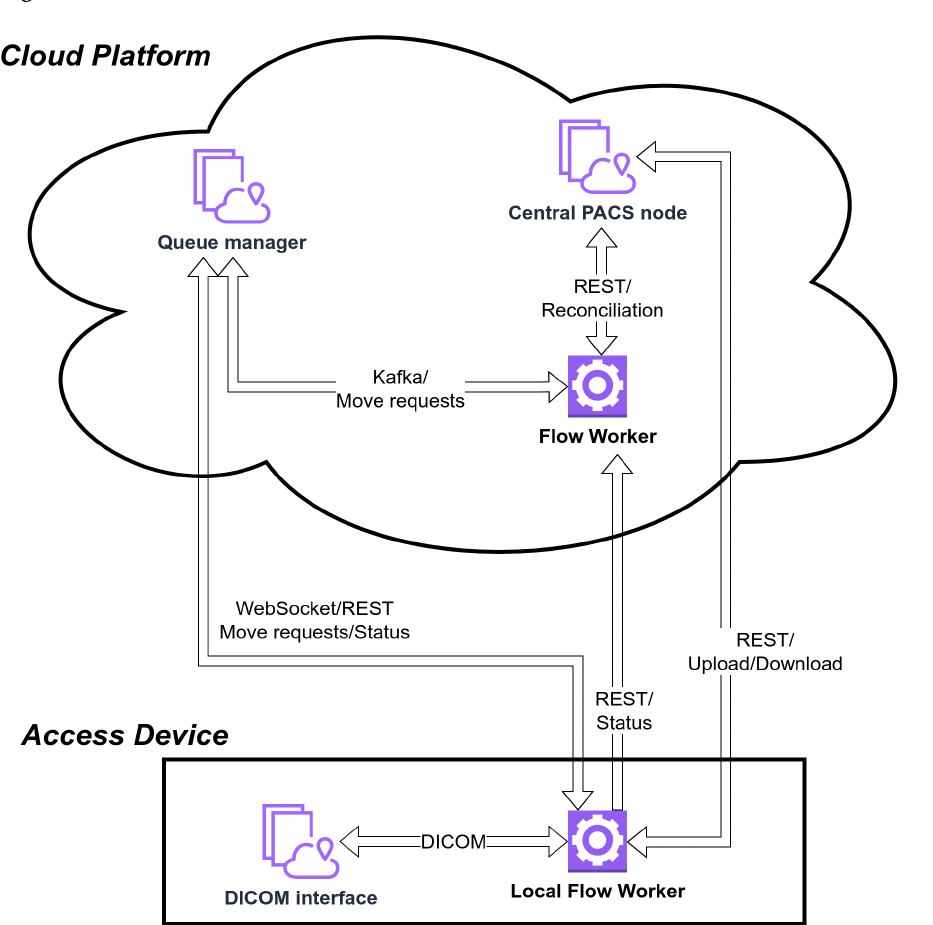
Figure 3. Connections between the access device and the cloud